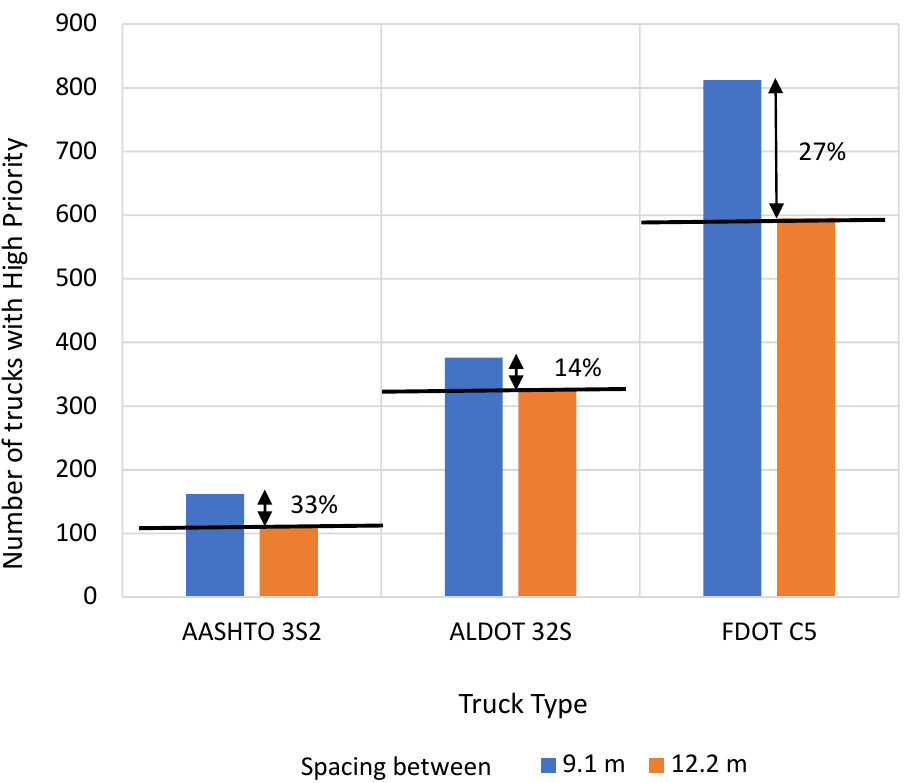
Figure 14. Number of high priority bridges for different truck types and truck spacing ([adopted from [103]).